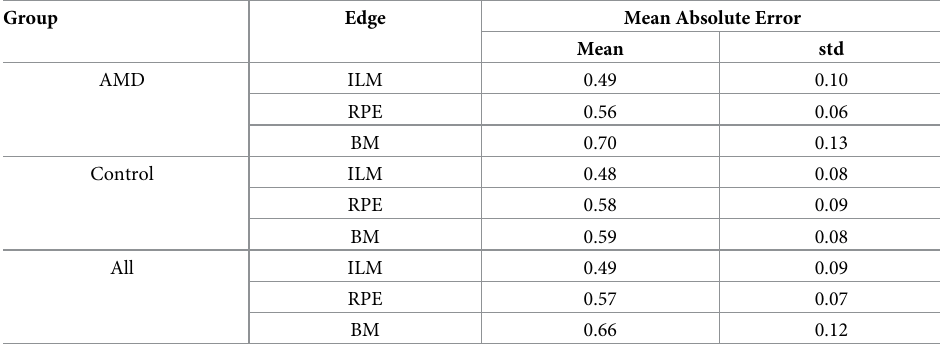
Table 1. The results of segmentation of the edges of the retinal layers. Group